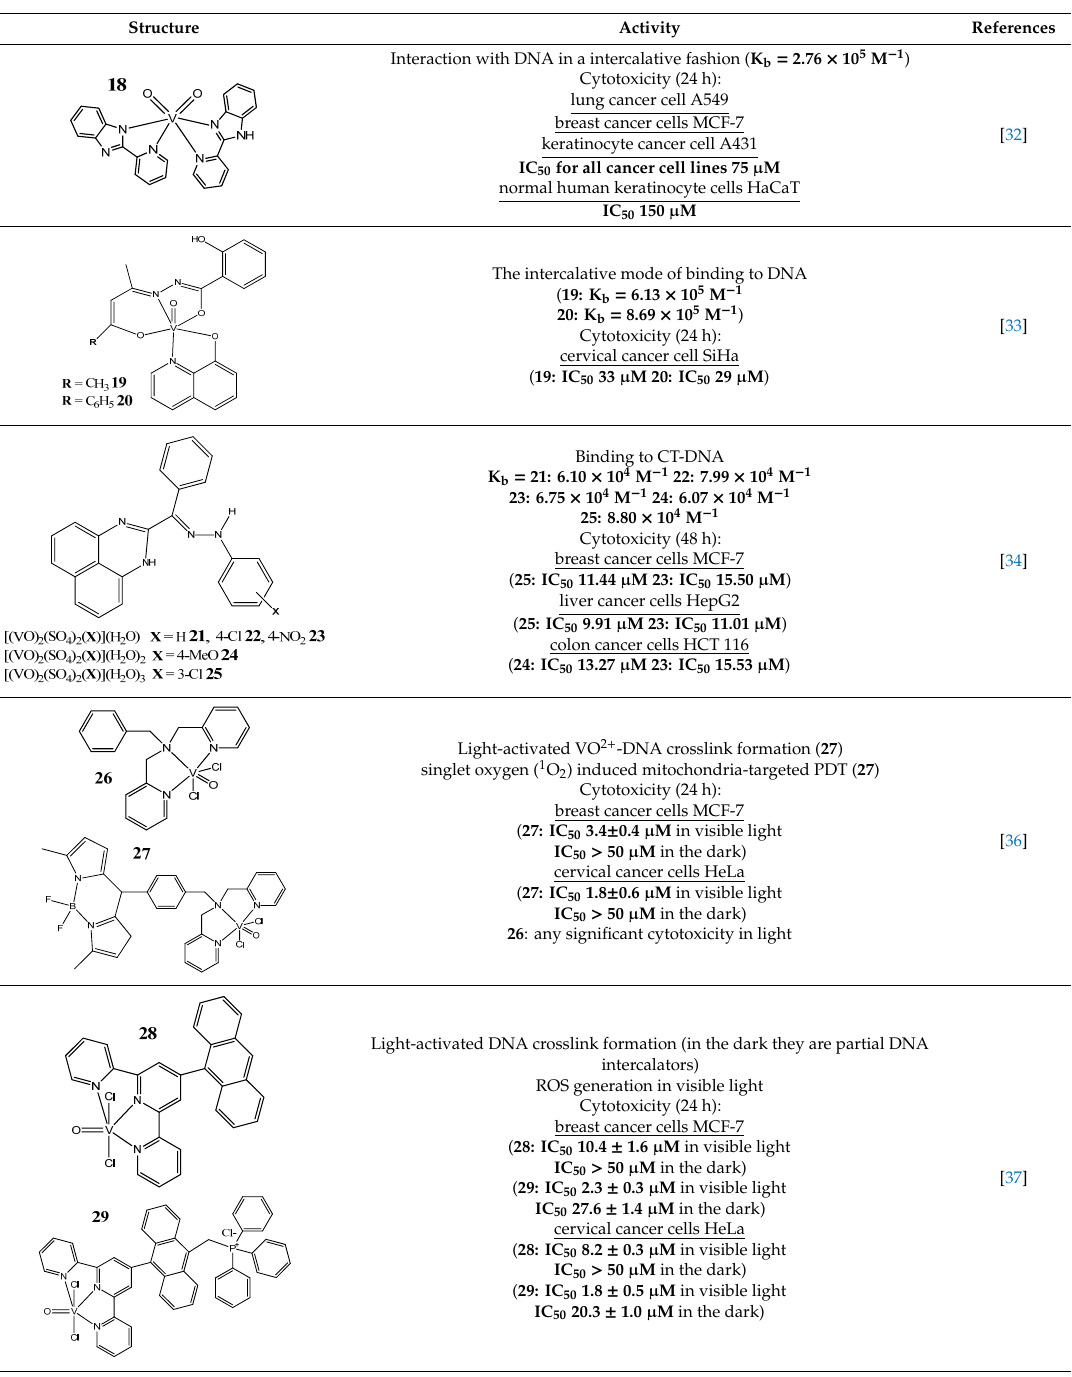
Table 1. Cont. Structure Activity